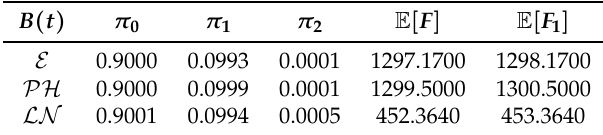
Table 4. π i , i = 0,1,2, E [ F ] and E [ F 1 ] , A ∼ PAR ( k , t min ) versus B ( t ) . B ( t )